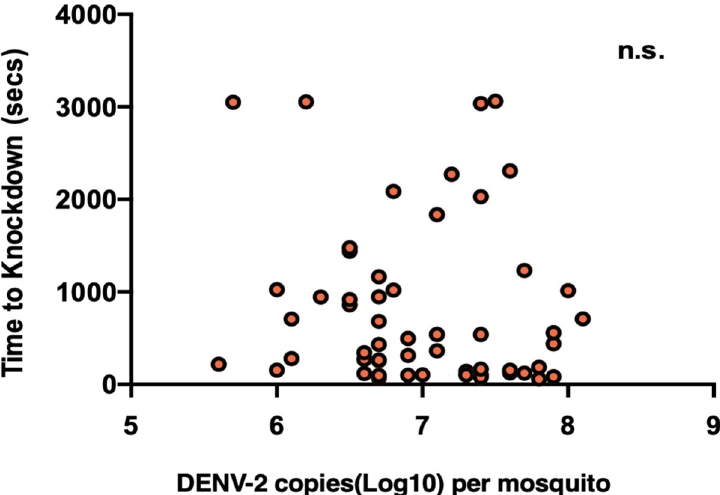
Fig 3. Relationship between viral load and thermal knockdown in mosquitoes. Relationship between knockdown time (seconds) and DENV load (per mosquito) in wildtype (D+/ W − ) mosquitoes. Each point represents a single mosquito with individuals from all 4 replicate experiments. There was no significant relationship (Pearson correlation, p > 0.05) between knockdown time and DENV load for the pooled set or for individual replicate experiments.